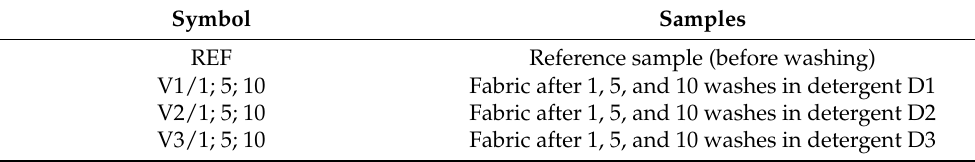
Table 3. List of test